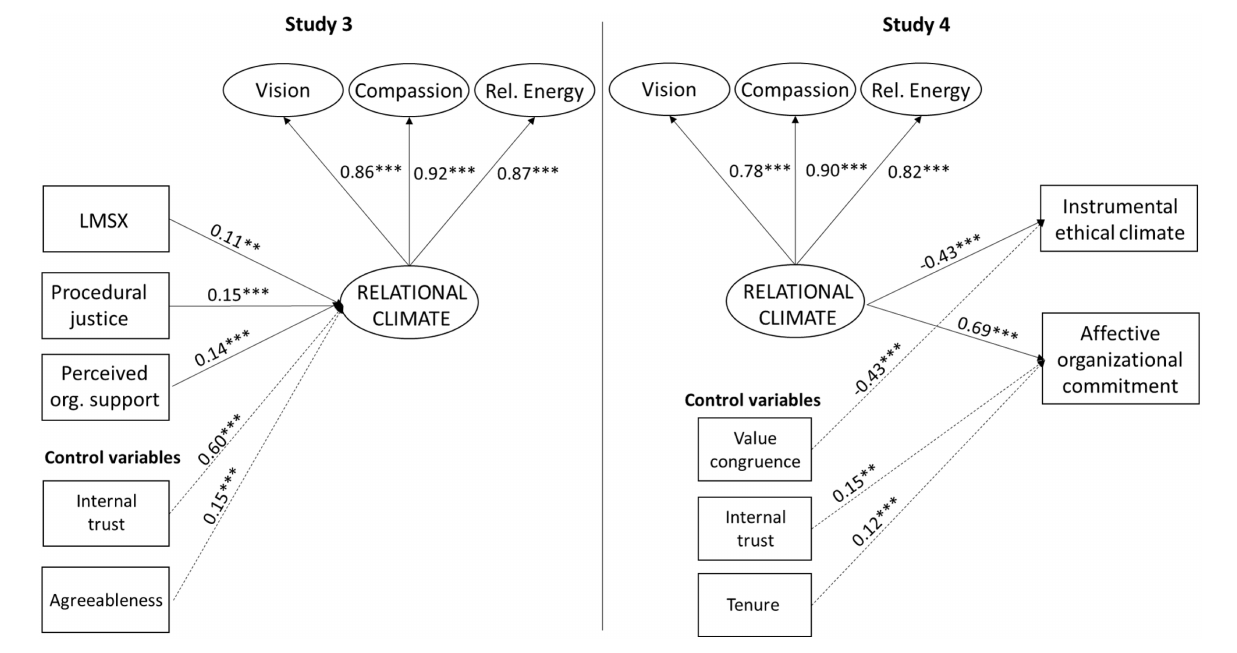
were made to minimize common method bias by loading all observed variables onto a common latent factor, statistical control is no substitute for multisource data. Thus, there is likely some inaccuracy in the strength of the relationships, although not necessarily in an upward direction (Conway and Lance, 2010). On average, the common latent factor